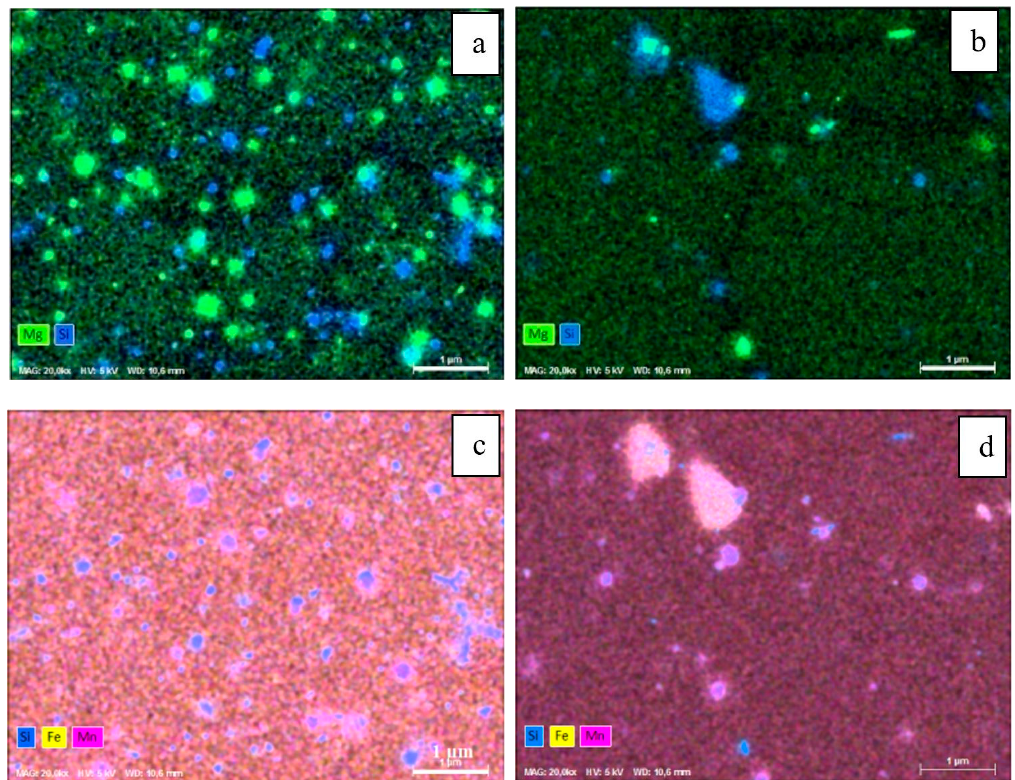
Figure 10. The distribution of Si, Mg, Fe, and Mn around ( a , c ) indent 5 with finer and ( b , d ) indent 6 with relatively coarser structure.